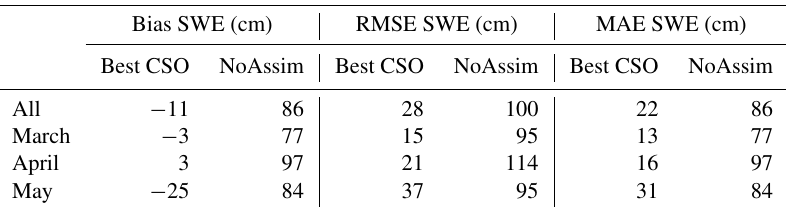
Table 2. Fieldwork results 2018. The 70 SWE measurements from the 2018 fieldwork compared to the best CSO simulation and the no assimilation (NoAssim) case using the three model performance metrics, i.e., root mean squared error (RMSE), mean bias error (bias), and mean absolute error (MAE).